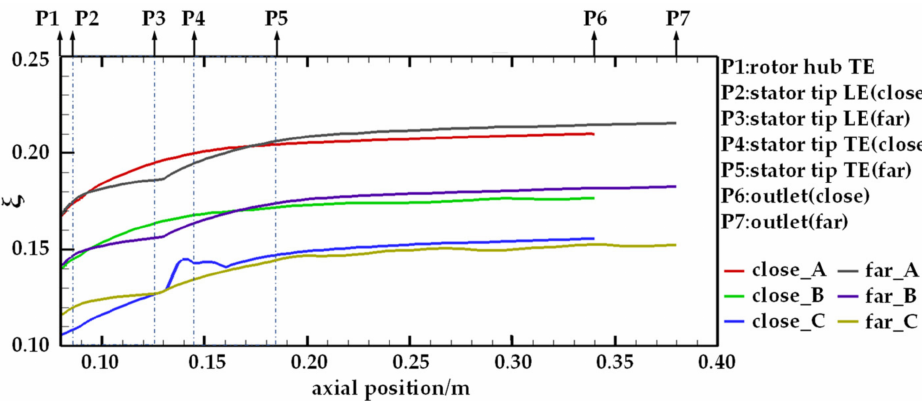
Figure 9. Loss generation from rotor TE to the